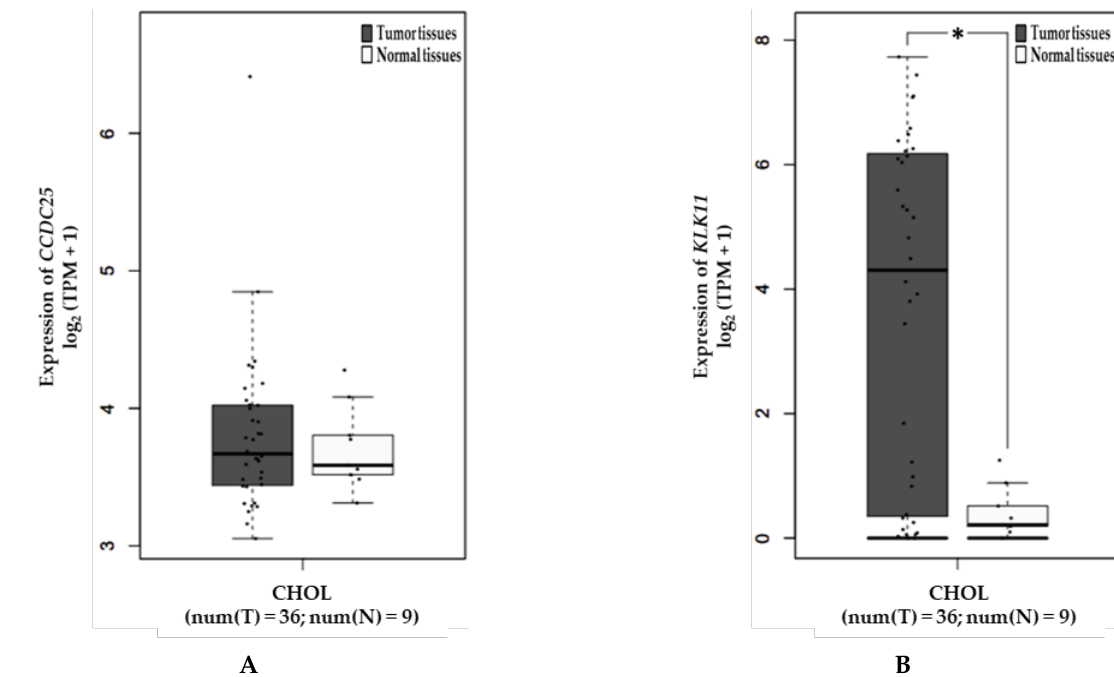
Figure 6. Expression of CCDC25 and KLK11 mRNA in CCA tissues analyzed by using GEPIA. ( A ) Expression of CCDC25 in CCA. ( B ) Expression of KLK11 in CCA. * Statistical significance ( p < 0.05).